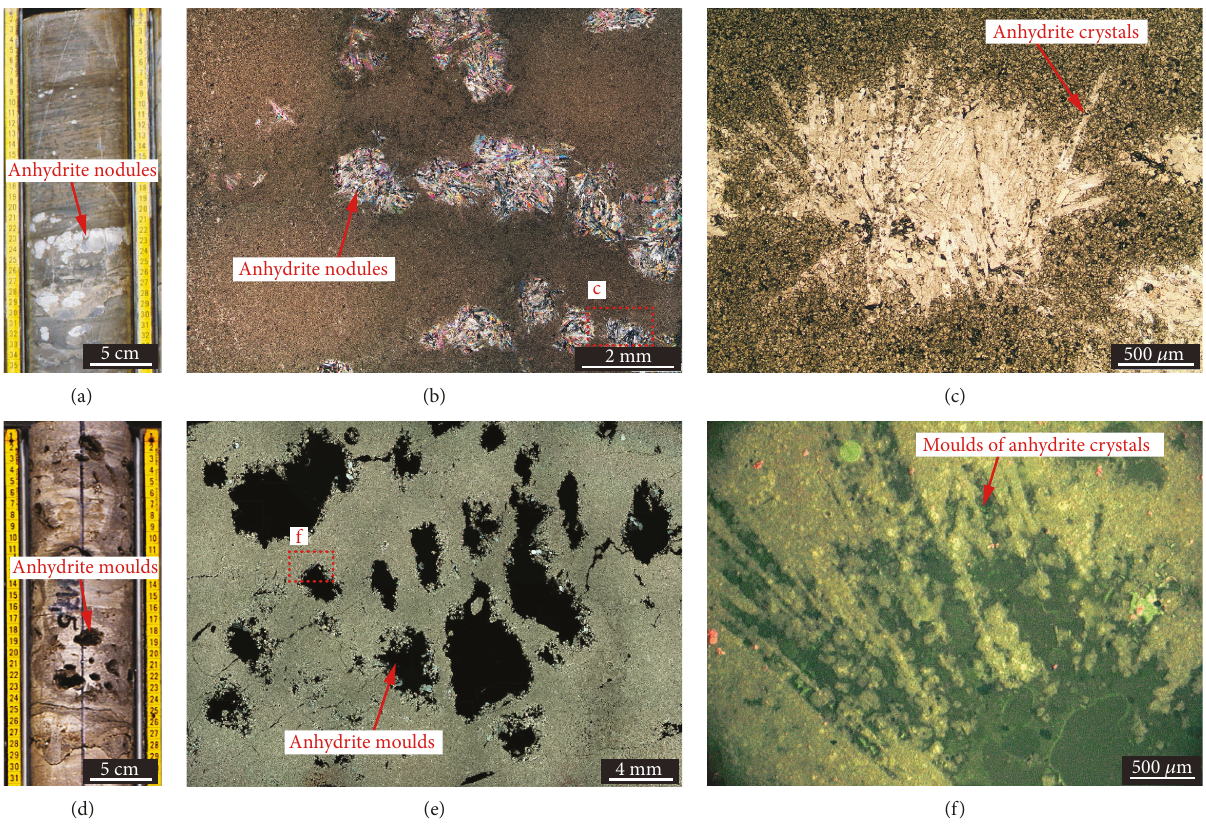
Figure 4: Muschelkalk dolostones with (a-c; SLA 1295.80) abundant eogenetic anhydrite nodules or (d-f; BEN 817.59m) with pores resulting from their dissolution. Photomicrographs in crossed-polarized, transmitted